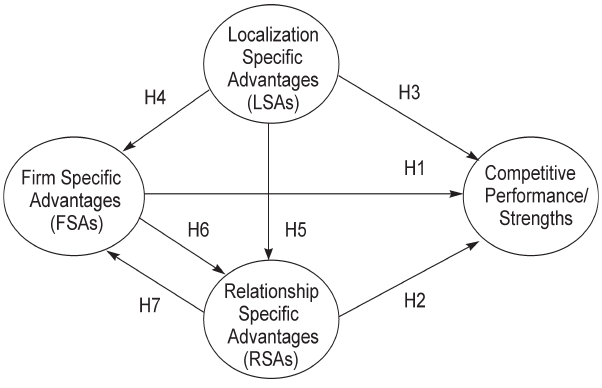
Fig 1. Structural model of relationships between Firm Specific Advantages, Localizational Specific Advantages, Relationship Specific Advantages and Business